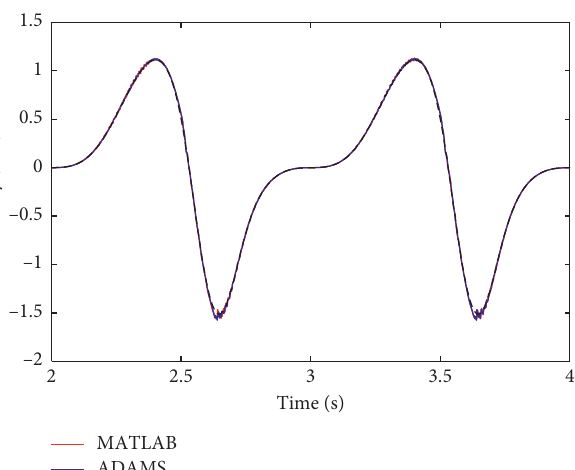
Figure 26: Velocity of the